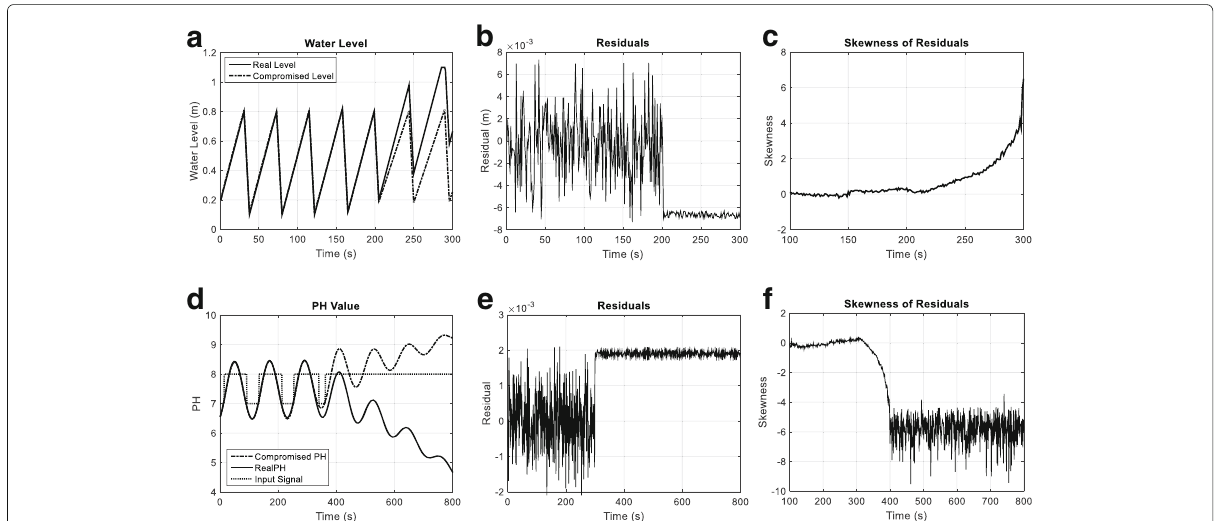
Fig. 8 Detection of the variant of surge stealthy attacks. When the variant of surge stealthy attacks in ( b ) and ( e ) are conducted on the water level control system and the pH value control system, respectively, the real water level shown in ( a ) deviates significantly from the seemingly normal but compromised water level, and the real pH value shown in ( d ) also deviates observably from the seemingly normal but compromised pH value. The significant changes of skewness coefficients of residuals shown in ( c ) and ( f ) indicate that the approach proposed can identity the variant of surge stealthy attacks effectively